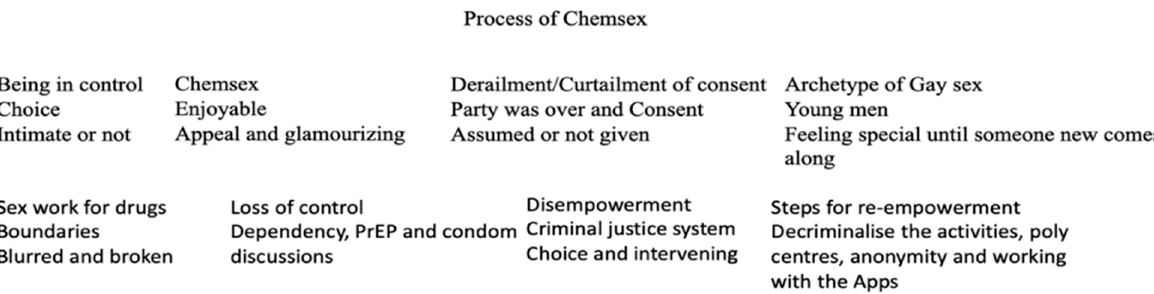
Figure 1. The Chemsex Consent Ladder—A Stepwise Process.